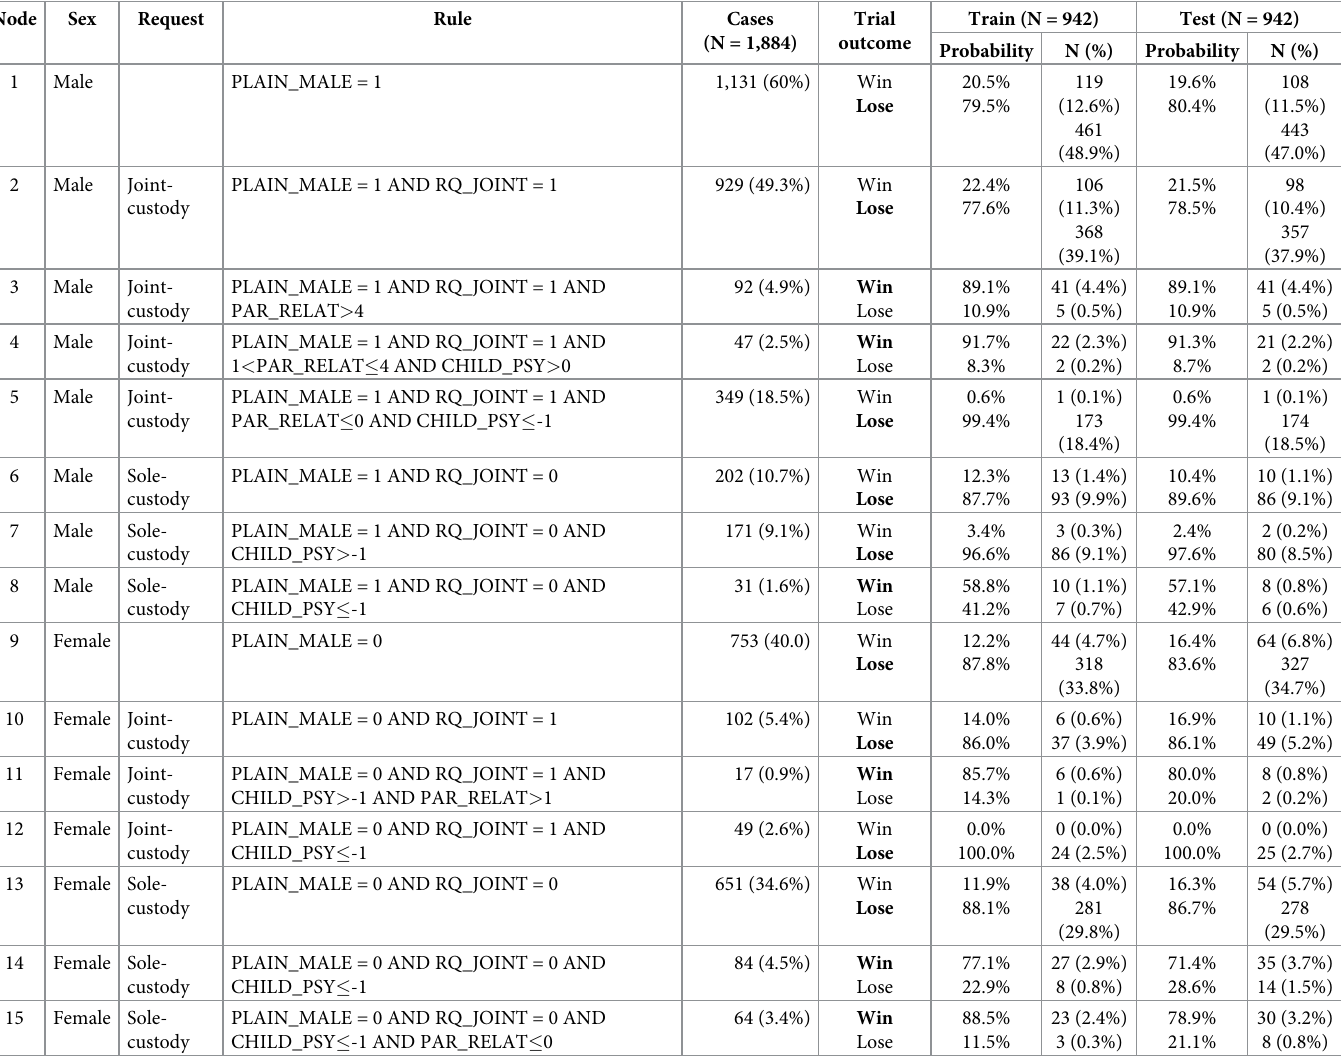
Table 8. Decision rules for the prediction of the trial outcome from the CHAID algorithm showing winning and losing